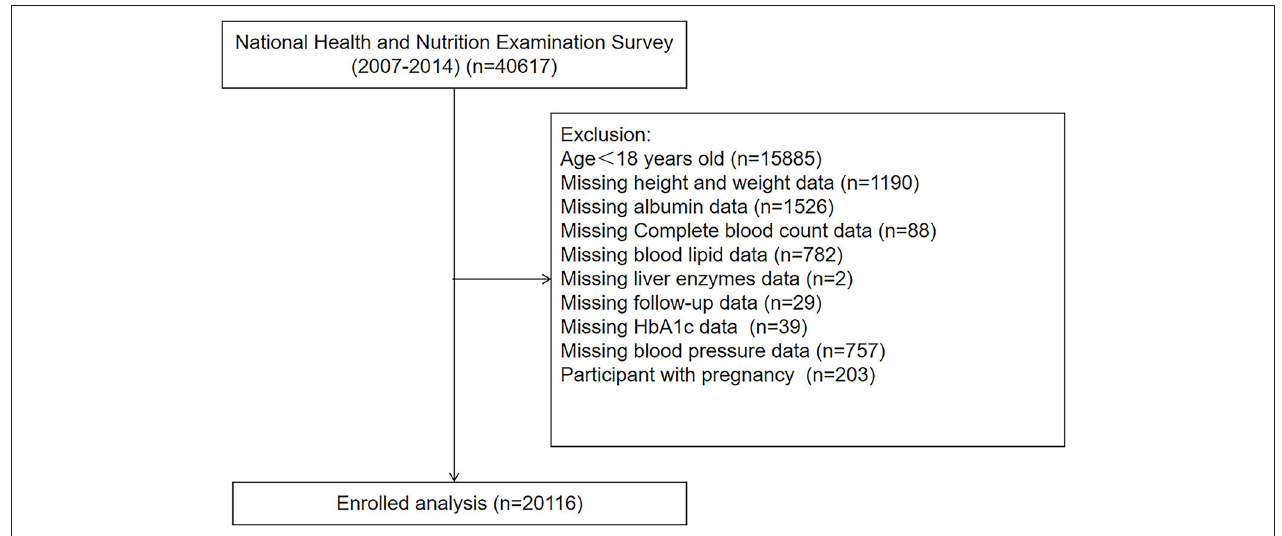
FIGURE 1 | The flow chart of participant selection.